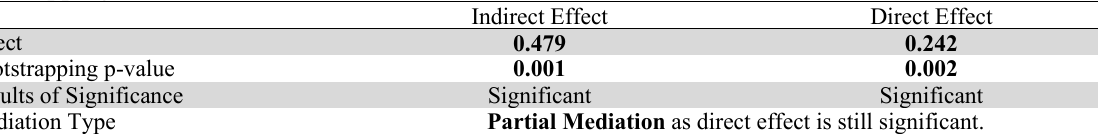
Bootstrapping Results of Mediation